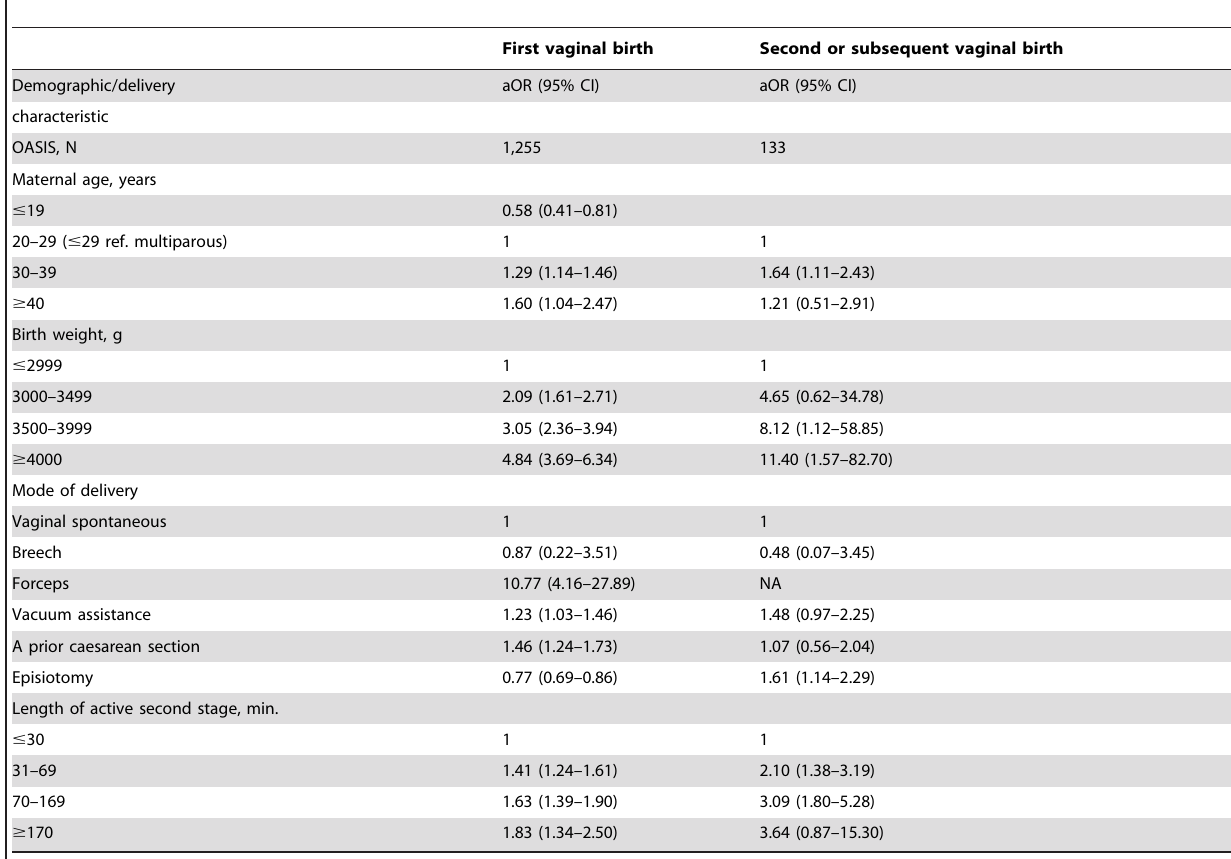
Table 5. Adjusted odds ratios (aOR) of OASIS for matched pairs of women with and without episiotomy separately for women with first vaginal singleton birth including women with first vaginal birth after a prior caesarean section and among women with second or subsequent birth from 2004–2011 in Finland (logistic regression